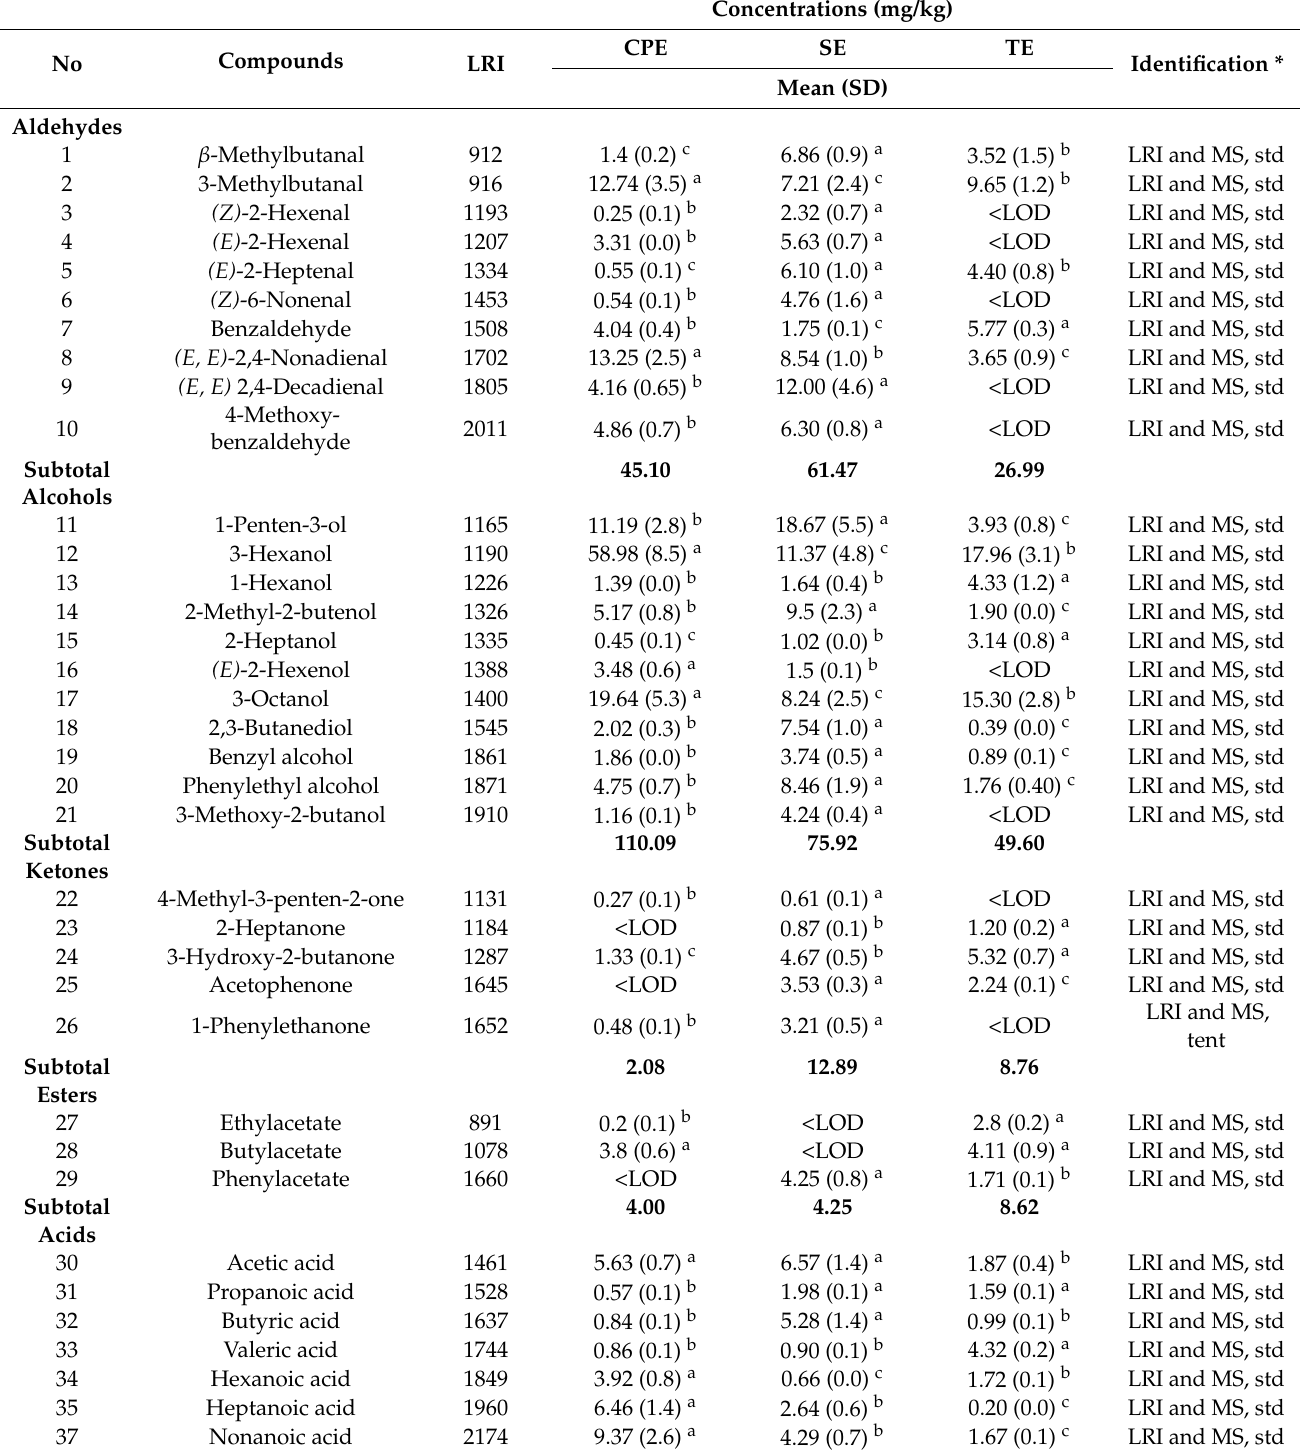
Table 3. Volatile compounds of shea butter extracted with CPE, SE and TE